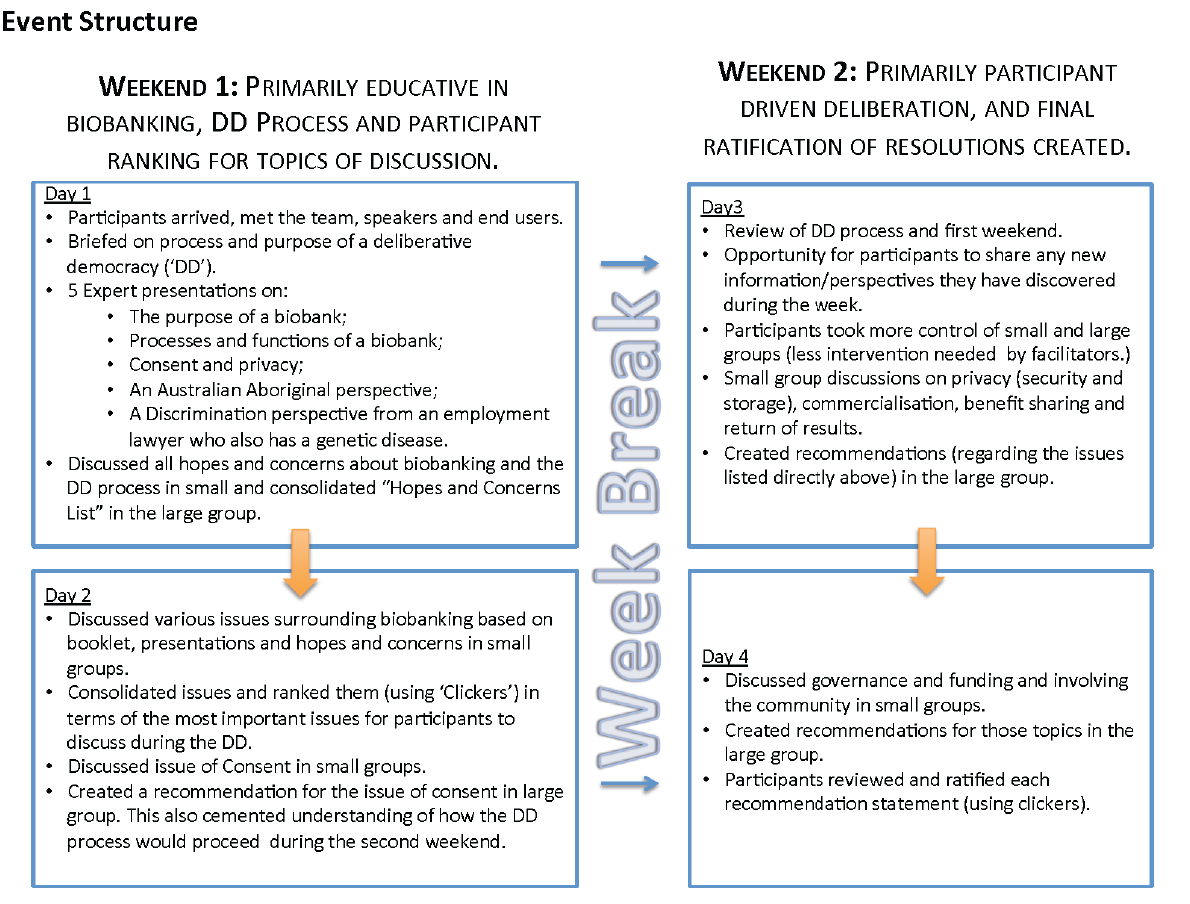
Figure 1. Content and structure of the deliberative democracy